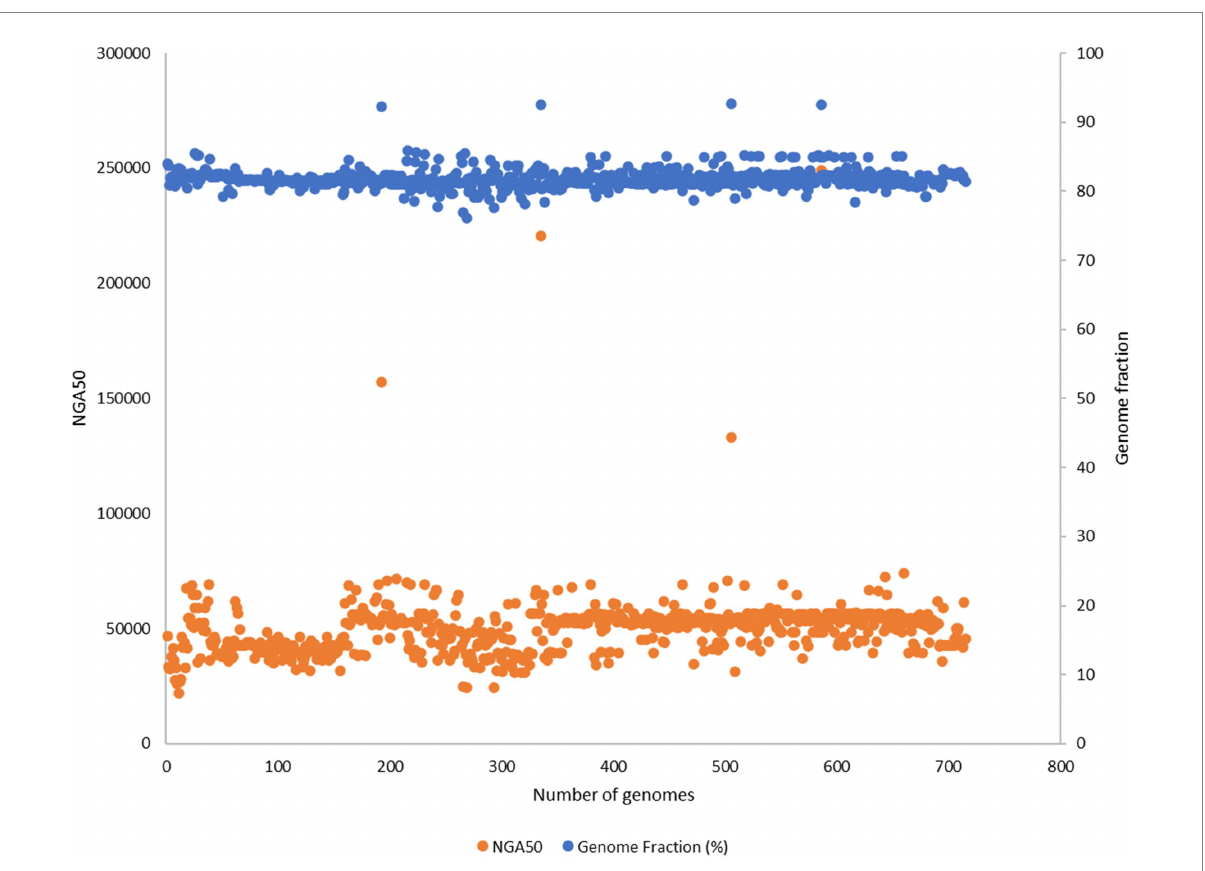
FIGURE 5 732 good quality genomes from PATRIC were subjected to quality metrics as defined by EUCAST (number of contigs <= 500, genome fraction >= 75%, NGA50 >= 20,000) and were used to identify good quality genomes for antibiotic susceptibility. 17 genomes did not qualify based on these criteria and were removed from subsequent analysis for implementing classification